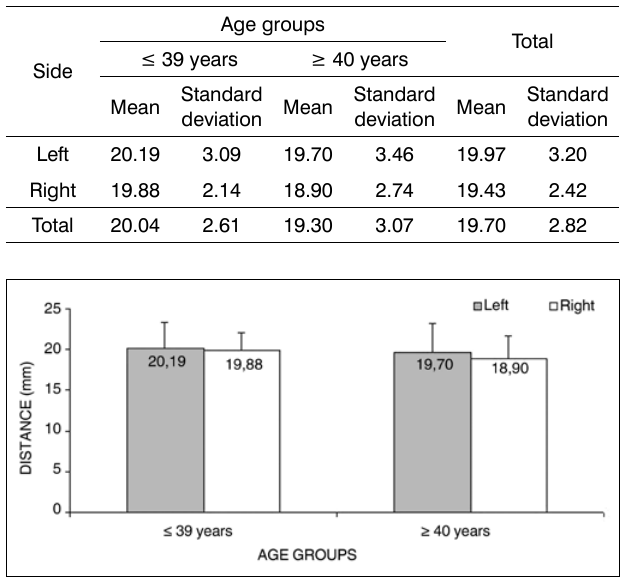
Table 7. Measurement 4 relative to age group and side. in mm.